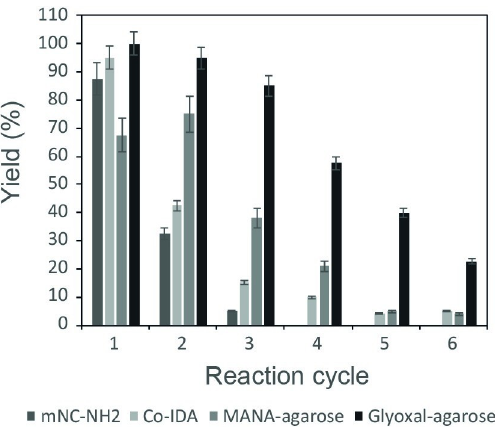
Fig 4. Pre-D-fagomine reaction yields catalyzed by FSA immobilized in mNC-NH 2 , Co-IDA, MANA-agarose and Glyoxal-agarose in subsequent reaction cycles. The reaction medium contained: 45 mM DHA, 30 mM β -CHO and 1 U mL -1 of reaction. The aldol addition was performed at 25˚C and pH 8.0 for 5 hours.